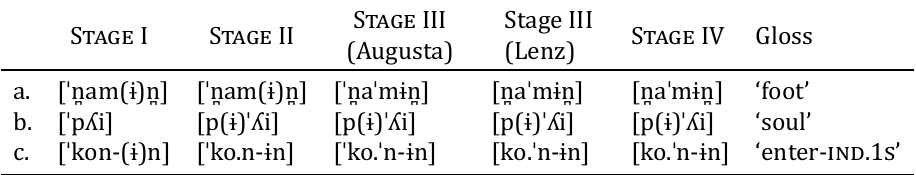
Table 23: Epenthesis (in parenthesis) vs. underlying [ɨ] and its relation to stress in the history of